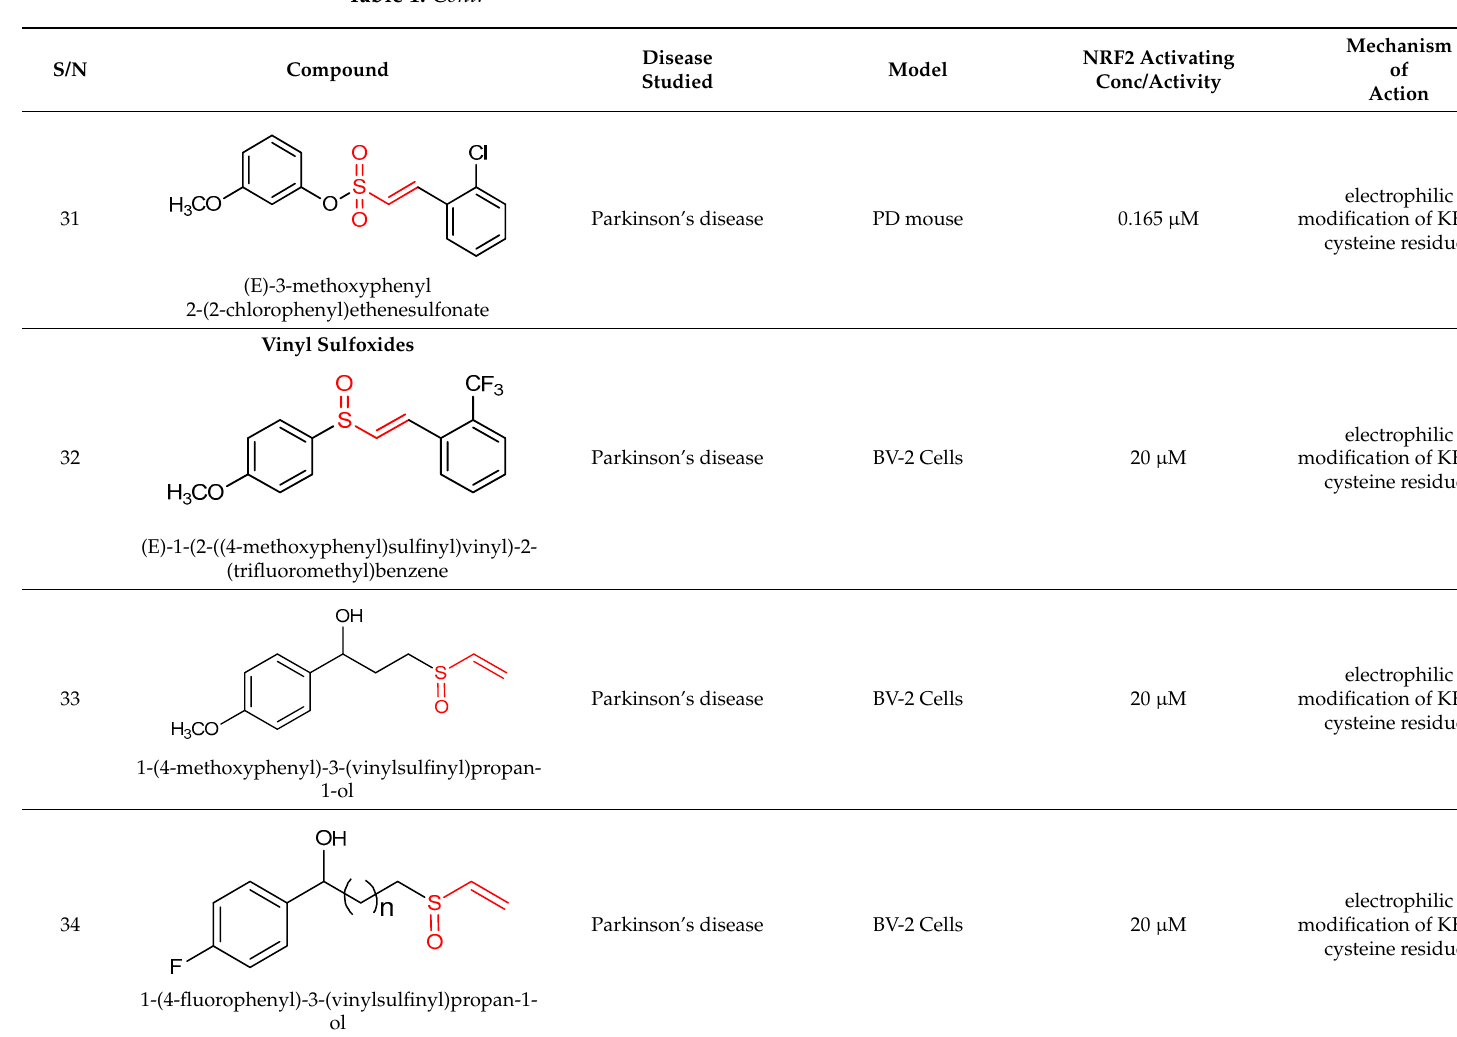
Table 2. α , β -unsaturated moiety-bearing NRF2 activators in clinical trial or approved by